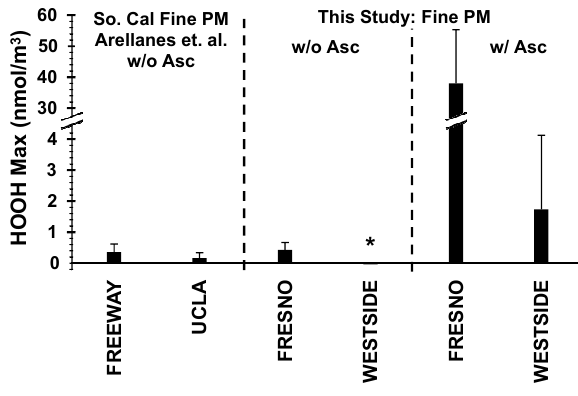
Fig. 4. Comparison of HOOH generation in SJV particles with re- sults for fine PM from southern California (Arellanes et al., 2006). Air-volume-normalized HOOH maxima (nmolm − 3 ) are shown. The Southern California fine PM samples were extracted for two h in an aqueous solution (0.10mM EDTA, pH 3.5, no ascorbate) (Arellanes et al., 2006). The asterisk indicates that HOOH forma- tion in these samples was not statistically different from